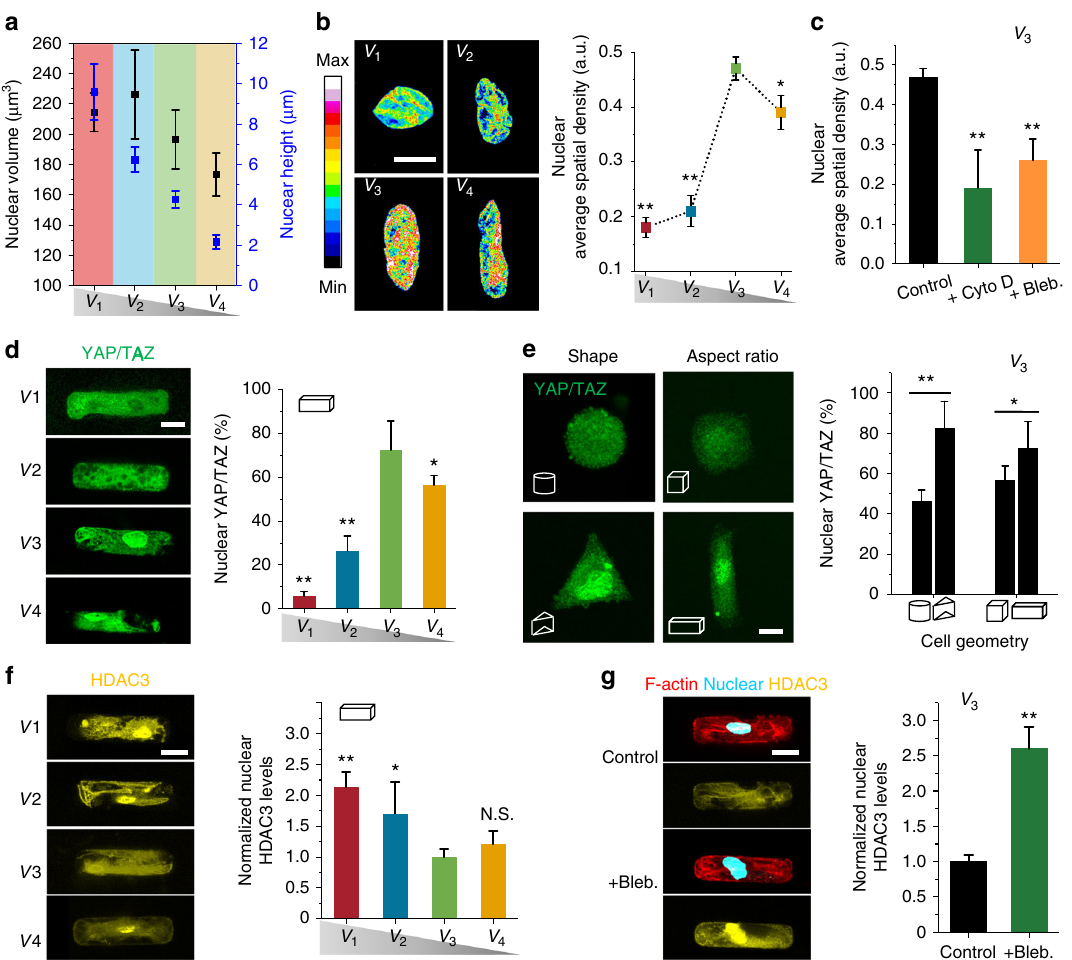
Fig. 4 Nuclear function and transcription factor activity a Nucleus volume and height as a function of cell volume. The volume of nucleus was calculated by fi tting the morphology of nucleus to an ellipsoidal shape. Data are given as mean ± s.d. with 12 ≤ n ≤ 15. b Quantitation of nucleus average spatial density (total DAPI intensity per nuclear volume) as a function of cell volume. Highly condensed domains show higher fl uorescence intensity. The scale bar is 5 μ m. c Quantitation of the changes in the level of nucleus average spatial density for cells with V μ M cytochalasin D (Cyto D) or 50 3 after treatment with 1 μ M Blebbistatin (Bleb). d Representative images and quanti fi cation of YAP/TAZ localization in hMSCs with different cell volumes but same geometry after 24 h. Scale bar 10 µ m. e Representative images and quanti fi cation of YAP/TAZ localization in hMSCs with different cell geometries but same volume after 24 h. Scale bar 10 µ m. f Representative images of hMSCs stained for HDAC3 on cells with different volumes but same geometry. Histogram shows nuclear HDAC3 levels as a function of cell volume. g Representative images and quantitation of cells with V 3 treated with 50 μ M Blebbistatin (Bleb). Data are shown as mean ± s.d. for all panels, n = 50 – 60 cells analyzed for each data point. * P < 0.05, ** P < 0.01 (ANOVA using a Tukey post-test). NS no signi fi